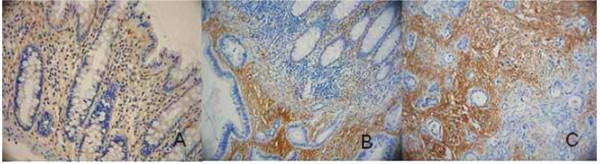
Immunohistochemical staining for PINCH. A) Weak PINCH immunohistochemical staining (yellow-brown colour) in distant normal mucosa. B) Moderate staining in the adjacent normal mucosa (top right corner of the picture) and strong staining in the primary tumour (lower left of the picture). C) Even stronger staining in lymph node metastasis.